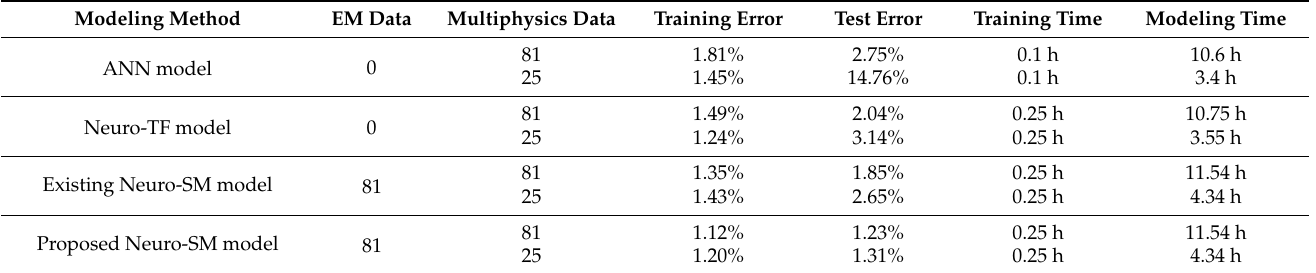
Table 2. Modeling results of four multiphysics parametric modeling methods for the iris coupled microwave cavity